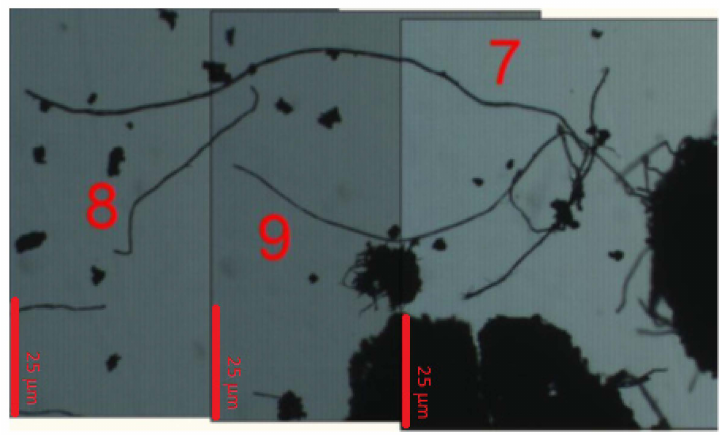
Figure 5. Size of long isolated fibers labeled according Table